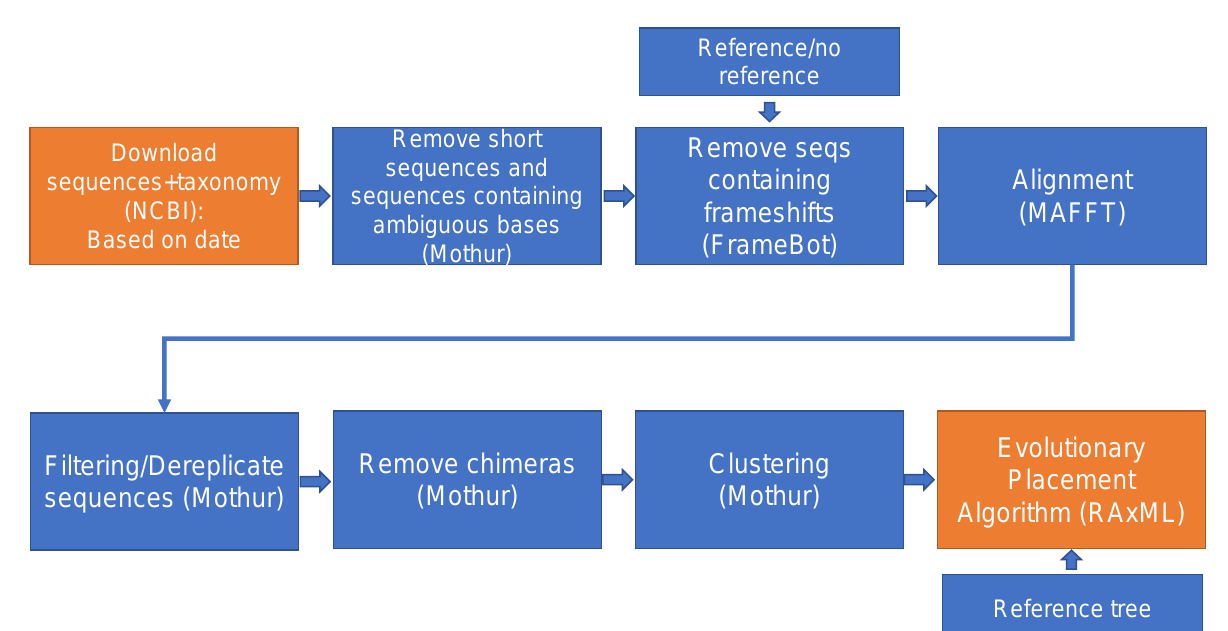
Figure 3. Workflow of the database-updating option of the PhyloFunDb pipeline. New sequences are downloaded, processed, filtered, clustered, and added to the tree and to the original database files. The steps that are different from the database-producing option are shown in